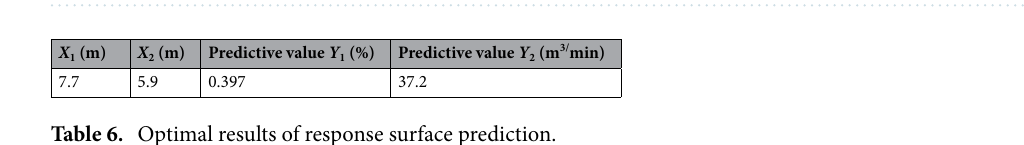
Figure 11. Response graph of the influence of various factors on the gas drainage volume in the roof low roadway (Design-Expert 10).